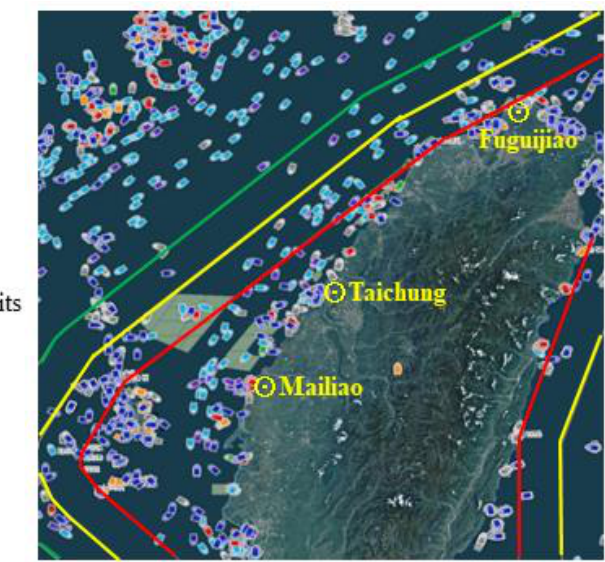
Figure 8. Crowded ship flows in the Taiwan Strait close to the Taiwan western coast. Source: plotted by the authors based on the information in Reference [30].